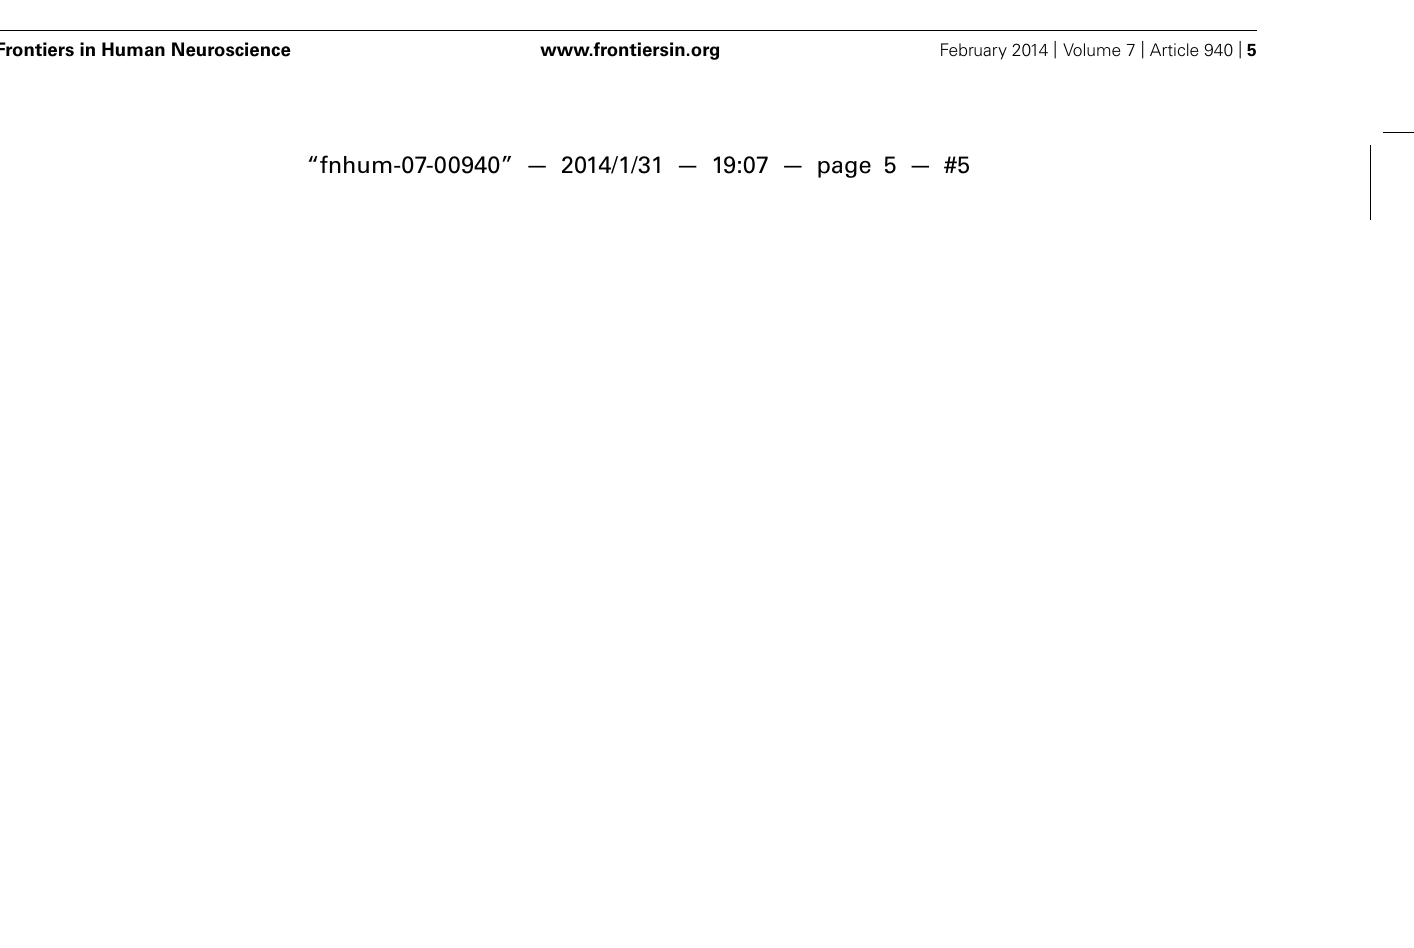
in each window.The blue curve refers to responses to fearful, the purple to angry and the yellow to neutral expressions.The X-axis represents the development of time (ms) with an increment of 10 ms for each time segment.TheY-axis represents the normalized signal power. The brain maps and curves for the gamma band are taken from Luo etal. (2007) with minor